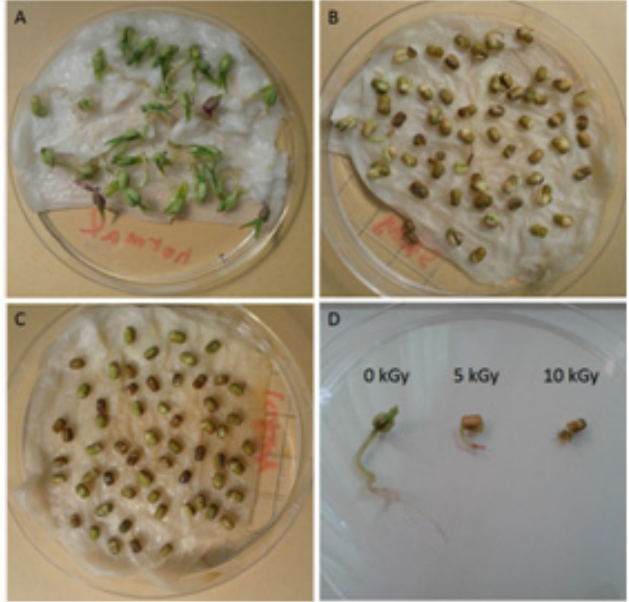
Figure 1. The phenotypic appearance of non-irradiated (0 kGy) and irradiated (5–10 kGy) mung beans. Seeds grown for four days without irradiation ( A ), with 5 kGy irradiation ( B ), or with 10 kGy irradiation ( C ) are shown in groups. For comparison, one seed from each condition is shown in parallel ( D ).